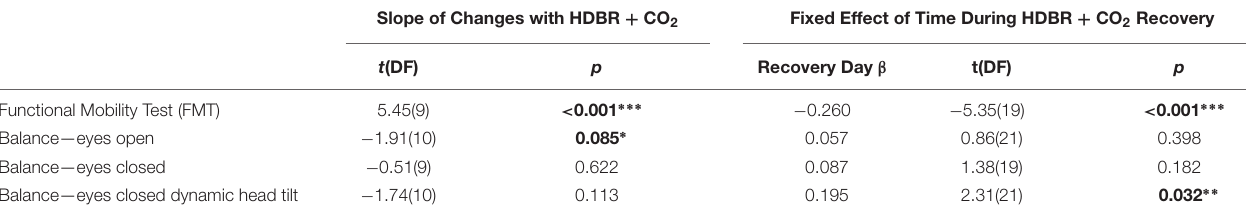
FIGURE 5 | Mobility and Balance Changes with HDBR + CO 2 . Mobility and balance performance pre- and post-HDBR + CO 2 . In general, participants showed performance declines followed by recovery post-HDBR + CO 2 . The slope of behavioral decline was significant for FMT and a trend for the balance-eyes open condition. Participants showed a significant linear recovery trajectory for FMT and balance-eyes closed dynamic head tilt. Error bars represent standard error. ∗ p < 0.10; ∗∗ p < 0.05; ∗∗∗ p < 0.001. TABLE 3 | Mobility and balance change with HDBR + CO 2 and recovery. Slope of Changes with HDBR + CO 2 Fixed Effect of Time During HDBR + CO 2